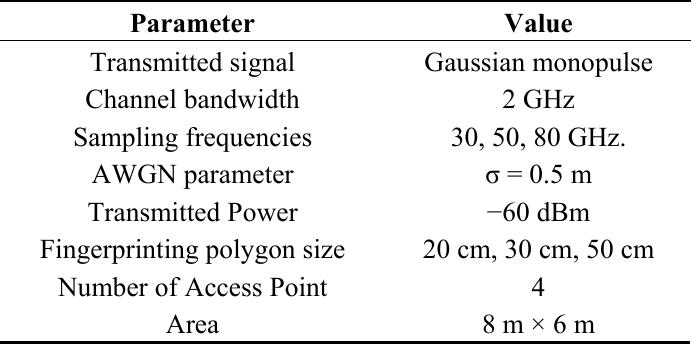
Table 1. Parameter values for evaluating model’s performance.